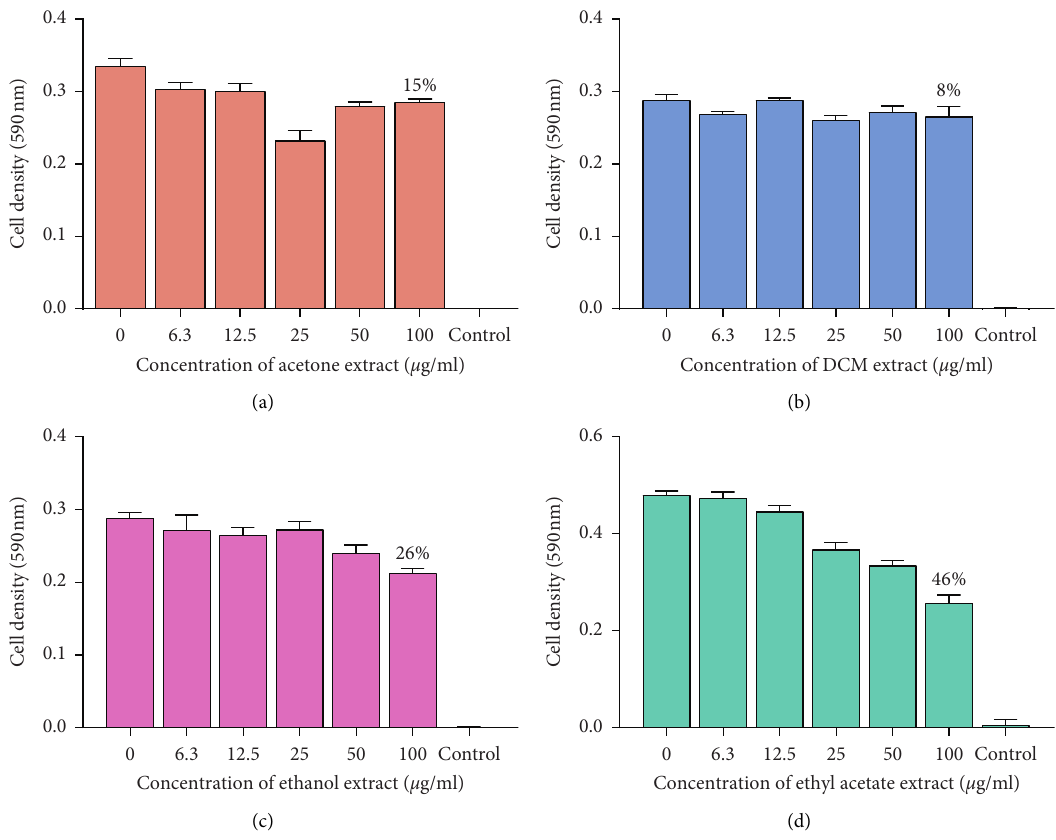
Figure 4: The effects of extracts of pods of P. thonningii against P. aeruginosa : (a) effect of acetone extract, (b) effect of DCM extract, (c) effect of ethanol extract, and (d) effect of ethyl acetate extract. Concentrations of extract ranged from 6.3 μ g/mL to 100 μ g/mL. Values are in mean cell density at 590nm wavelength ± the standard deviation; N �